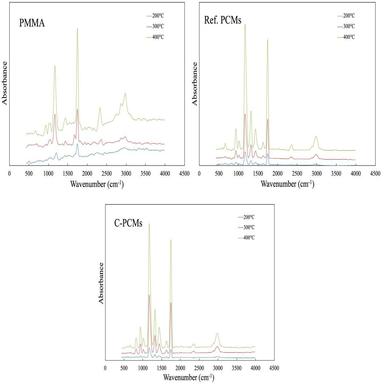
Infrared spectrum of gas produced by PMMA, Ref. PCMs and C-PCMs.